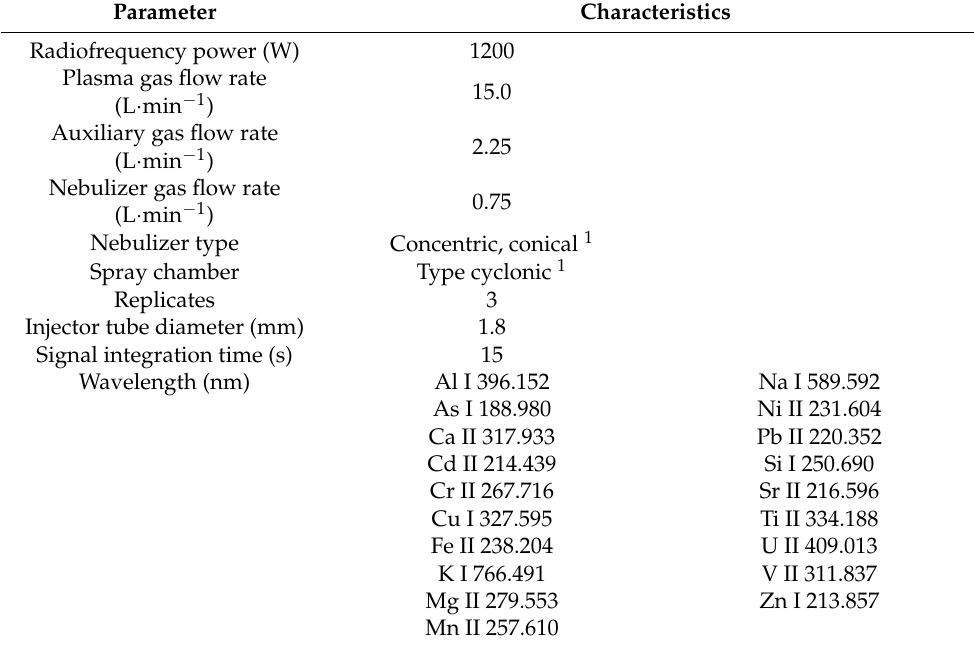
Table 2. Characteristics and operating conditions used for the analysis by ICP-OES with the axial